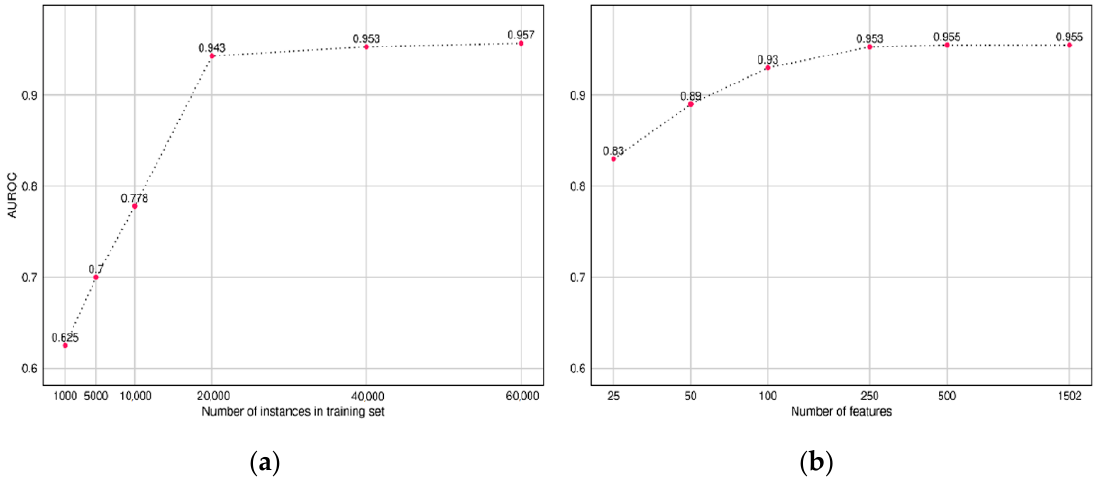
Figure 7. Performance of the CNN model across different sizes of ( a ) training data and ( b ) feature set.